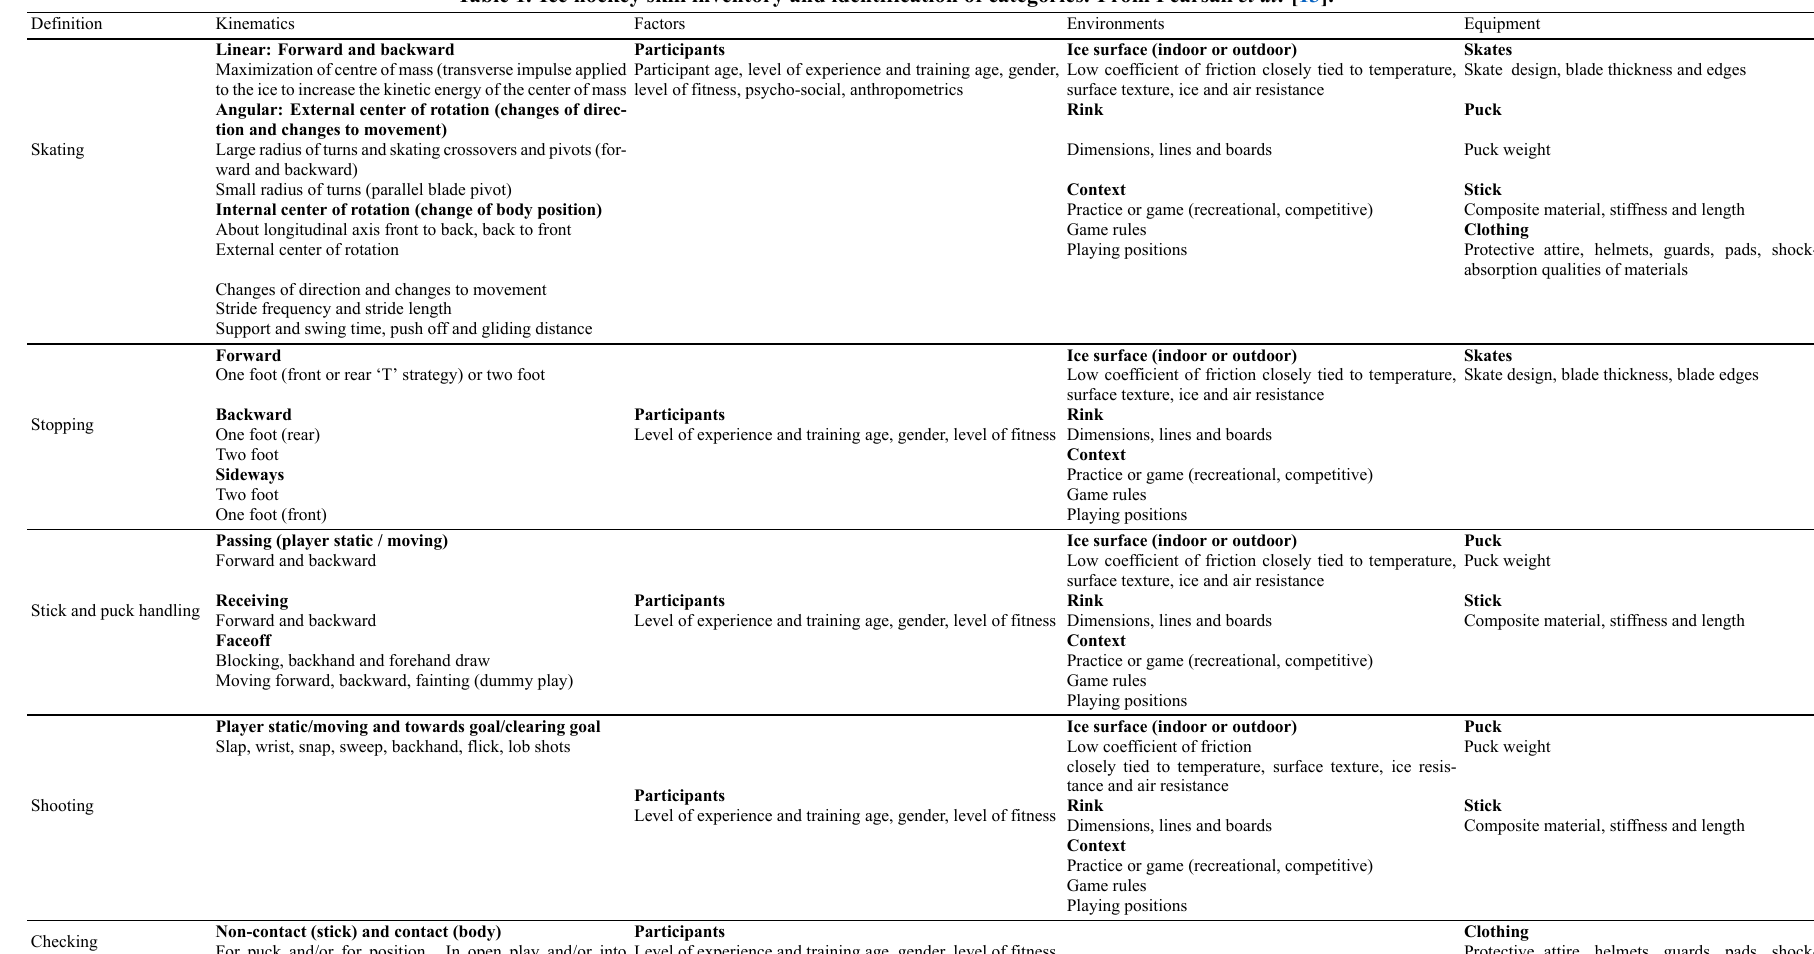
Table 1. Ice hockey skill inventory and identification of categories. From Pearsall et al .